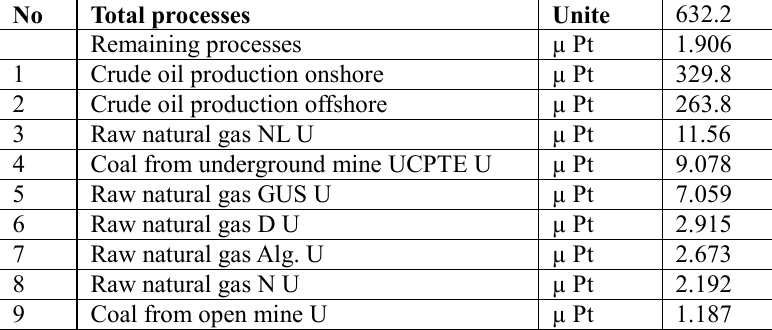
Fossil fuel sub processes weighting